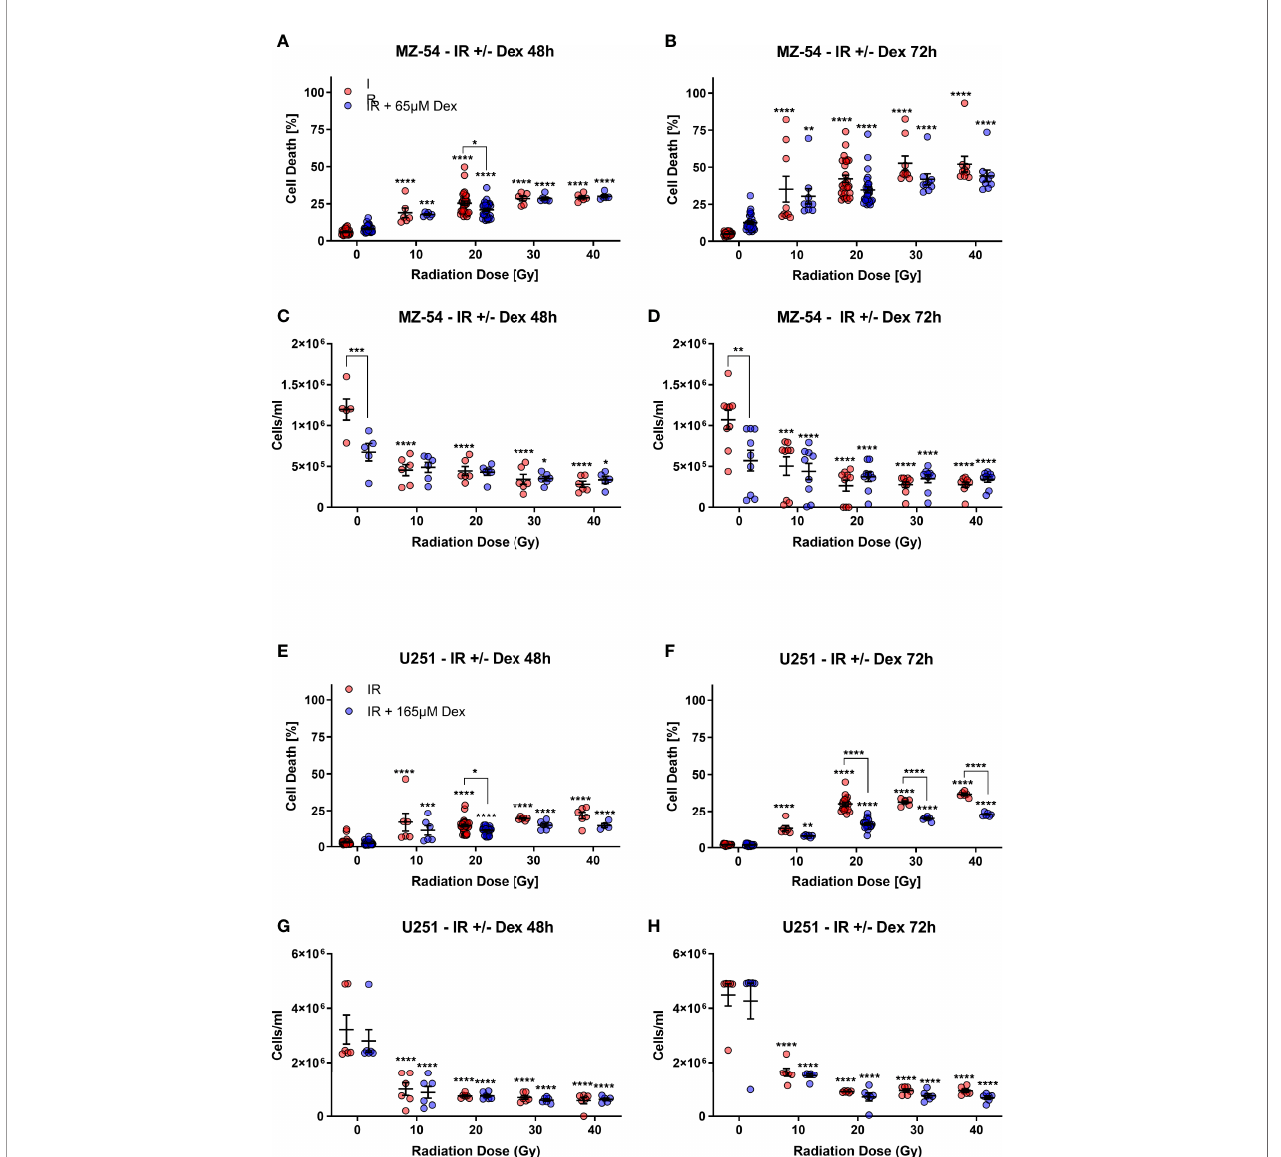
FIGURE 2 | FACS-based measurement of (A, B) cell death and (C, D) cell count of MZ-54 GBM cells after 24h pre-treatment with Dex and irradiation (IR). The measurements were conducted (A, C) 48h and (B, D) 72h after IR-treatment. MZ-54 show dose-dependent increases in cell death and concomitant decreases in cell counts, with no discernible effect through the addition of Dex. FACS-based measurement of (E, F) cell death and (G, H) cell count after (E, G) 48h and (F, H) 72h of U251 GBM cells treated accordingly show similar IR-dose-dependent increases and decrease in cell death and cell count respectively. Note that U251 cells are protected from IR-induced cell death after additional Dex-treatment. *p < 0.05; **p < 0.01; ***p < 0.001; ****p < 0.0001; Two-Way ANOVA with Dunnett ’ s multiple comparison test (GraphPad Prism